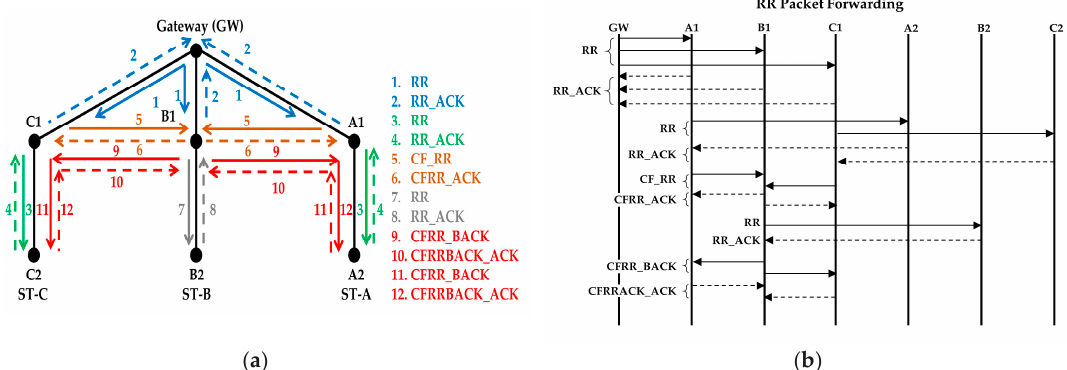
Figure 5. ( a ) Transmission sequence of RR, RR_ACK between the gateway and the neighbors and transmission of RR, RR_ACK, CF_RR, CFRR_ACK, CFRR_BACK and CFRRBACK_ACK between the layers and the adjacent nodes ( b ) The same transmission sequence is also shown in message sequence diagram.